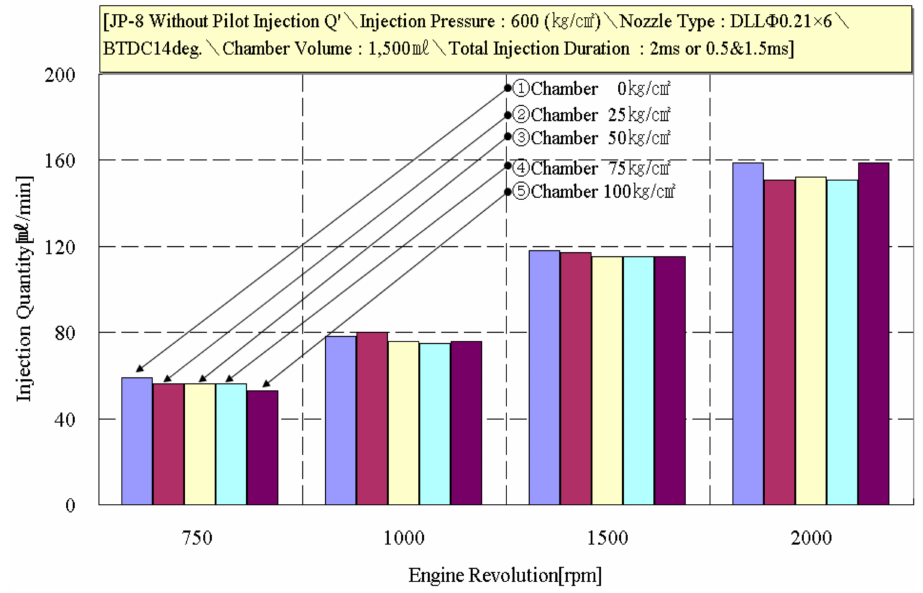
Figure 14. Injection Quantity on Engine Revolution without Pilot Injection of JP-8 Aviation